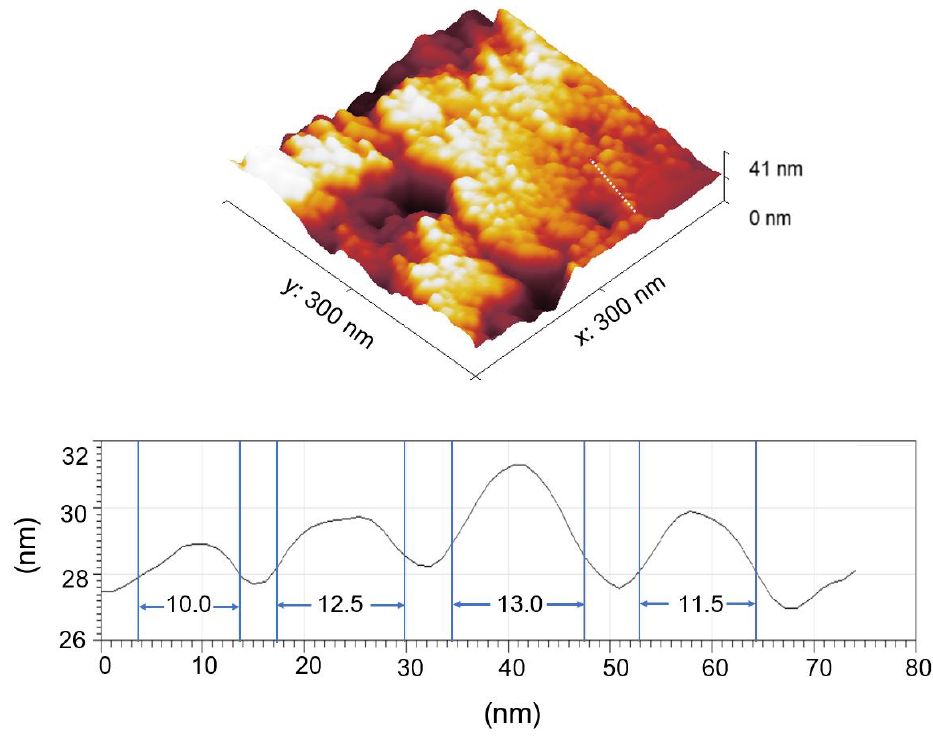
Figure 6. Topography of G-M@T magnetic nanoparticles.